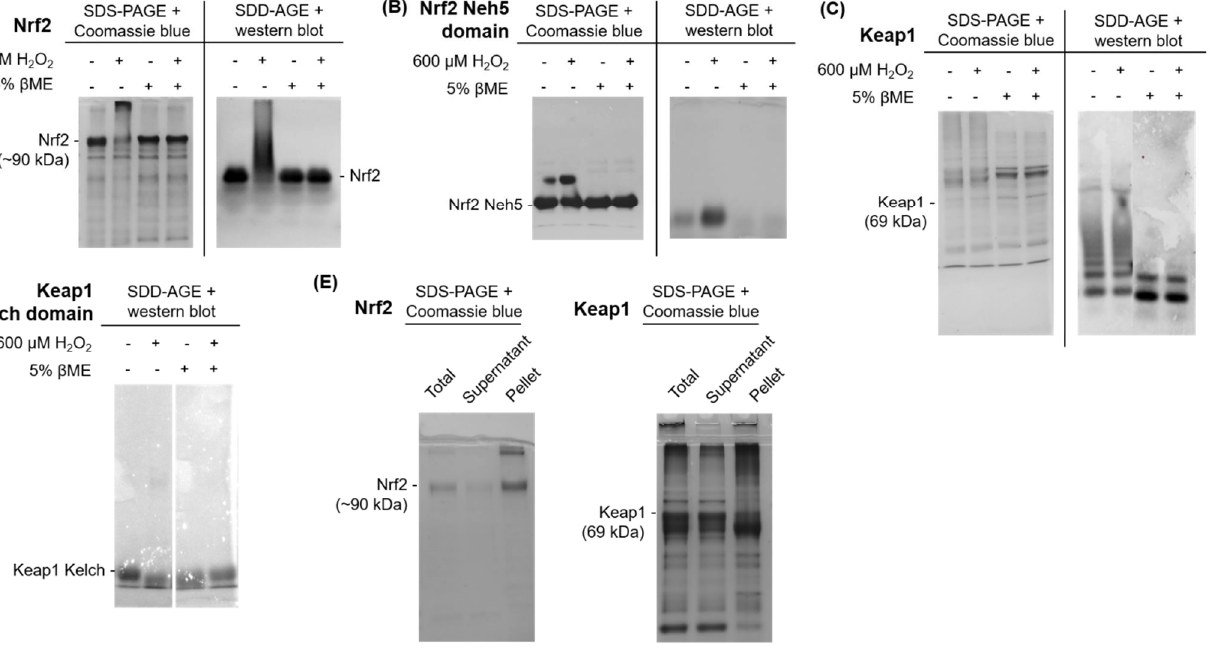
Figure 8. Nrf2 and Keap1 purified proteins aggregate upon exposure to oxidative stress in vitro. Purified protein treated with 600 µM H 2 O 2 ± βME for 30 min for ( A ) full-length Nrf2, ( B ) Nrf2′s Neh5 domain, ( C ) full-length Keap1, and ( D ) Keap1′s Kelch domain. ( E ) Fractionation assay for purified full-length Nrf2 and Keap1 protein. All purified proteins were resolved using SDS-PAGE with Coomassie Blue gel staining and/or by SDD-AGE with western blot detection, as indicated. Similarly, purified full-length Keap1 protein was treated with 600 µM H 2 O 2 in the